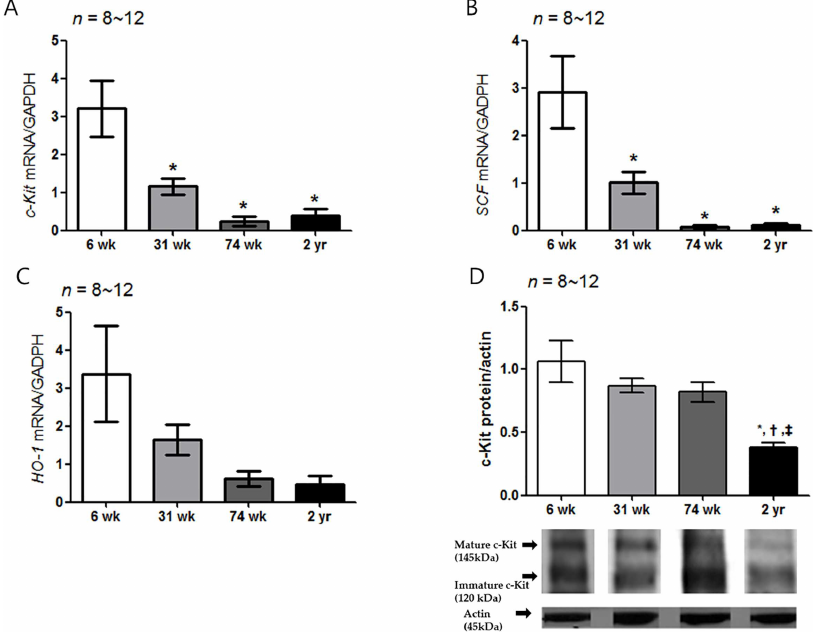
Fig 5. Expression of c-Kit , SCF , HO-1 mRNA and c-Kit protein. (A) The expressionof c-Kit mRNA by real- time PCR decreased with age. The c-Kit mRNA expression decreasedsignificantlyin the 31-, 74-wk-oldand 2-yr-oldrats comparedwith the 6-wk-oldrats ( P = 0.002 vs . 31-wk-oldrats and P < 0.001 vs . 74-wk- and 2-yr- old rats): 6-wk-oldrat group( n = 10), 31-wk-oldrat group( n = 10), 74-wk-oldrat group( n = 8) and2-yr-old rat group( n = 12). (B) The SCF mRNA expression of other agedrat group was significantly lower than that of the 6-wk-oldrat ( P = 0.004 vs . 31-wk-oldrats; P < 0.001 vs . 74-wk- and2-yr-old rats) ( n = 8–12).(C) No statistical differencewas showedthe HO-1 mRNA expression in different age rat group.(D) The c-Kit proteinexpression decreased with age. The c-Kit proteinexpression of 2-yr-old rats was lower than that of the other agedrat groups( P < 0.001 vs . 31-wk-oldrats; P = 0.001 vs . 74-wk-oldrats and P = 0.009 vs . 2-yr-old rats) ( n = 8–12). The results are shownas the mean valueof the opticaldensity (OD). The opticaldensitiescorrespondingto the mature (145 kDa) andimmature (120 kDa) forms were combinedin the analysisprocessusingdensitometry. Each bar represents the mean ± SE. * P < 0.05 comparedwith 6-wk-oldrats. † P < 0.05 comparedwith 31-wk- old rats; ‡ P < 0.05 comparedwith 74-wk-oldrats.